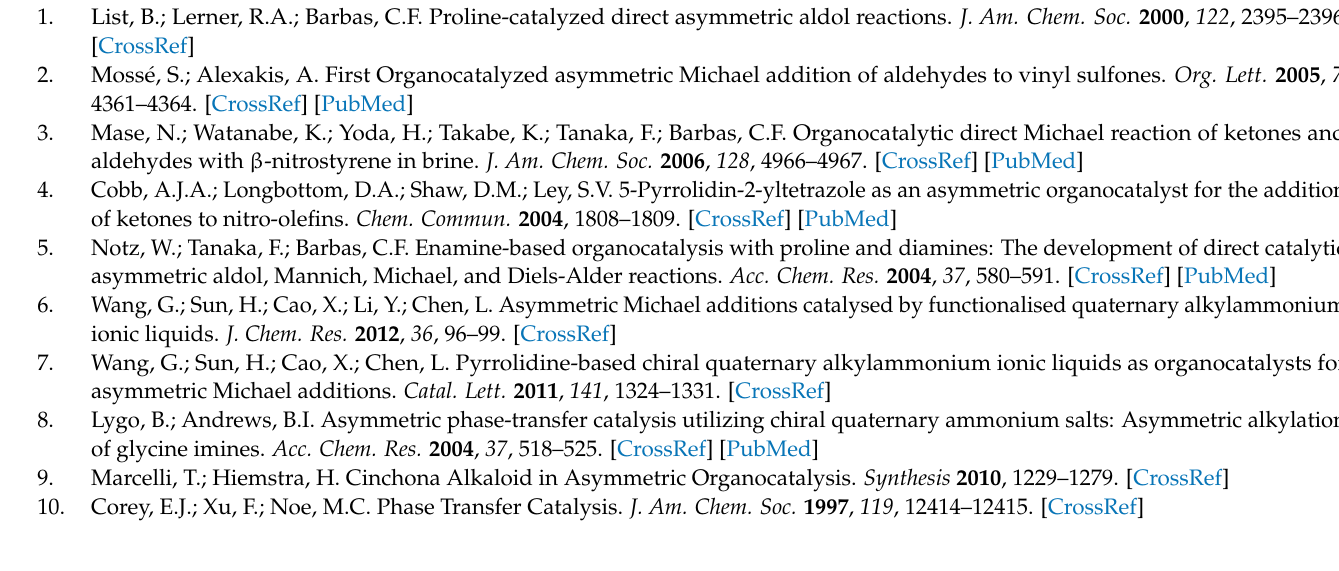
1H- and 13C-NMR spectra of 2 . Figure S2: 1H- and 13C-NMR spectra of 3 . Figure S3: 1H- and 13C-NMR spectra of 4 . Figure S4: 1H-NMR spectrum of 5 . Figure S5: 1H- and 13C-NMR spectra of 6 . Figure S6: HPLC chromatograms and Mass spectrum of 6 . Figure S7: TGA-DSC diagram of 6 . Figure S8: IR Spectra of 6